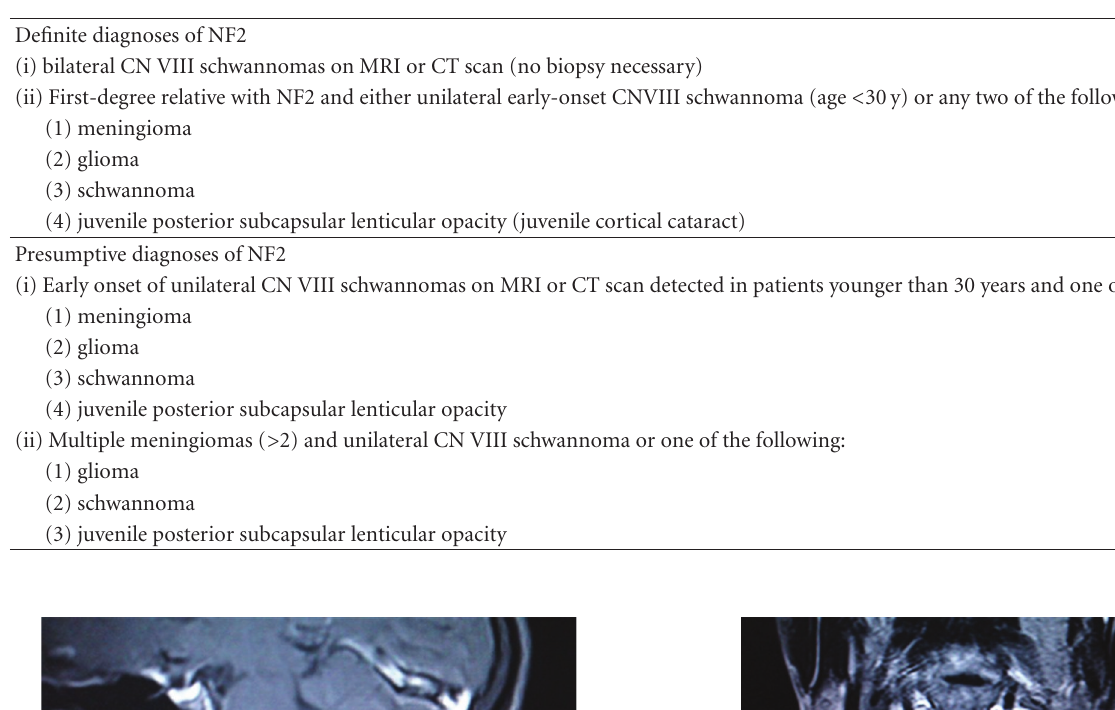
Table 1: Gutmann et al. [1].